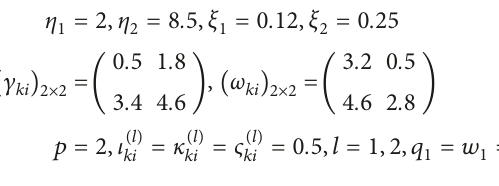
Figure 4: (a) Trajectories of x response system under controller